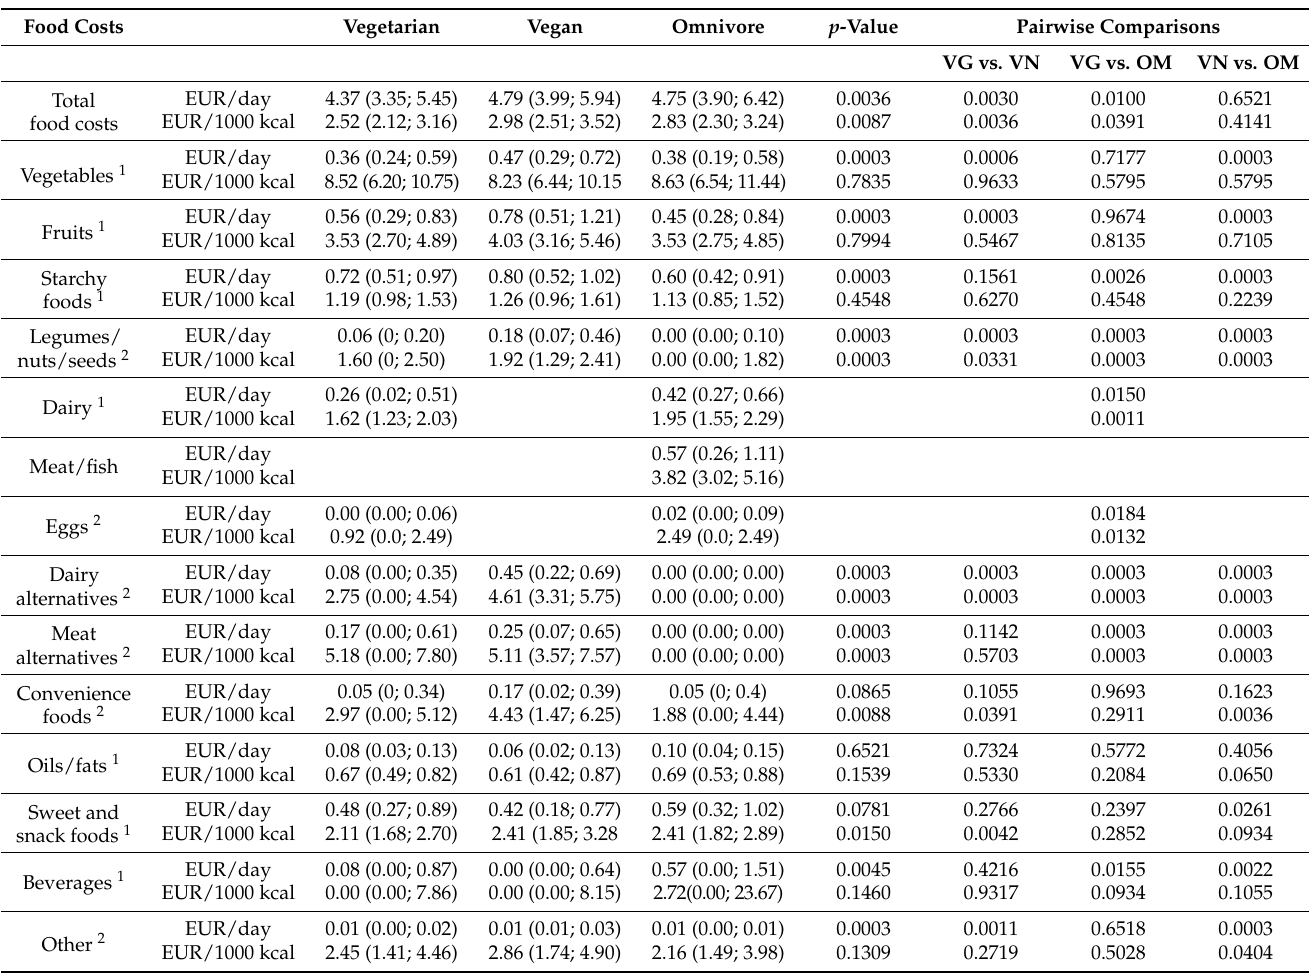
Table 3. Total food costs and food group costs (EUR/day; EUR/1000 kcal) among participants of the VeChi Youth Study (n = 390), stratified by diet